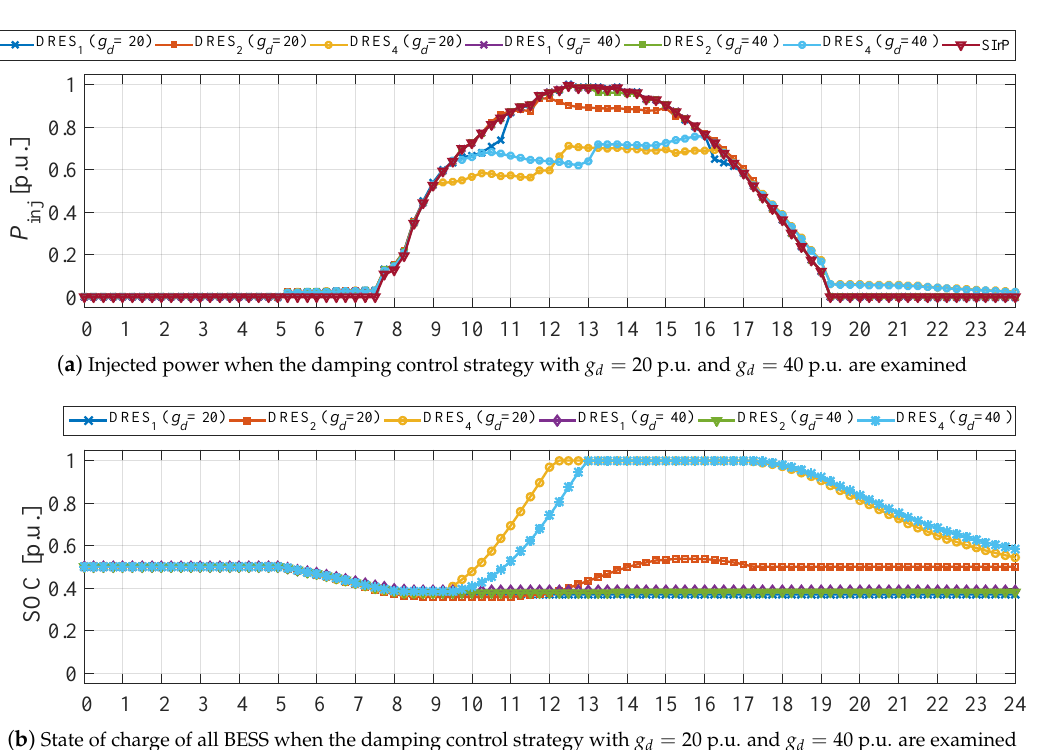
Figure 10. Injected power and SOC of all DRES when the the three-phase damping control strategy is examined (C2S4 and